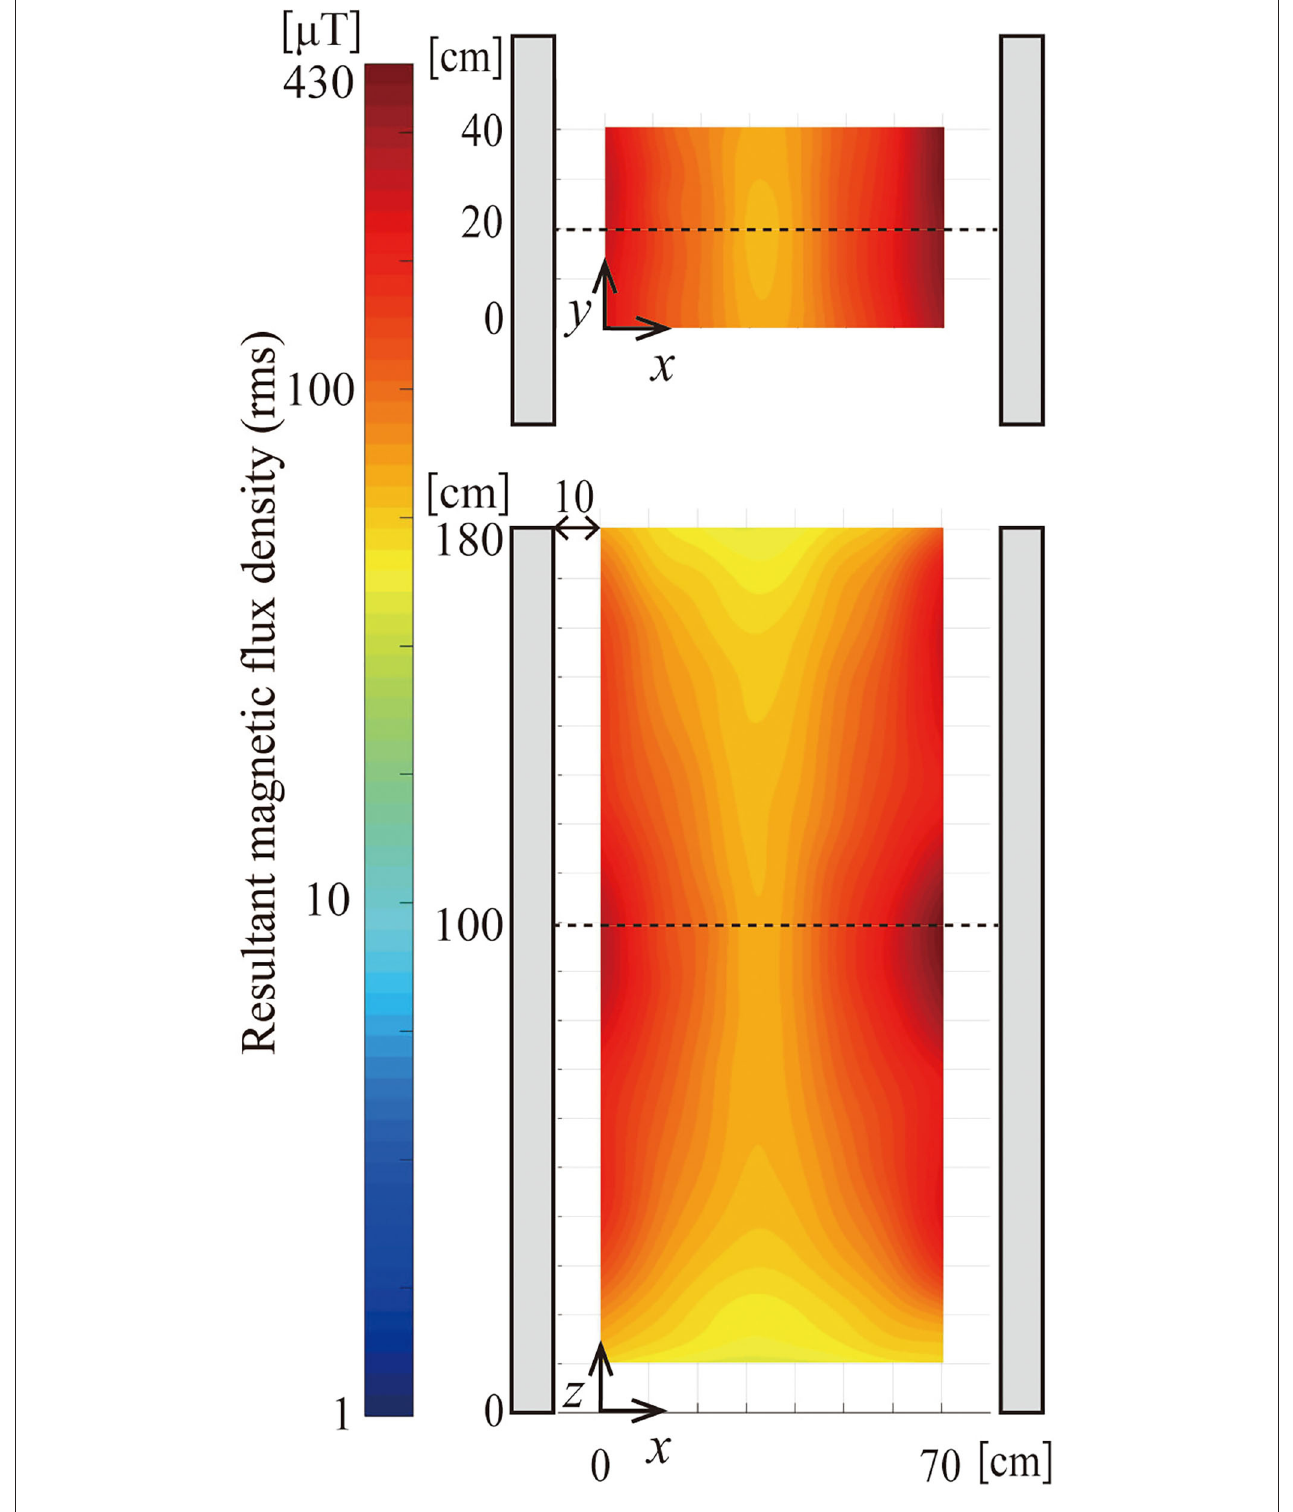
FIGURE 3 | Distribution of magnetic field of EAS gate G1 (366Hz) in zone A. Magnetic field was expressed in resultant rms value of magnetic flux density. The xy -cut is at z = 100cm and the xz -cut is at y = 20cm.